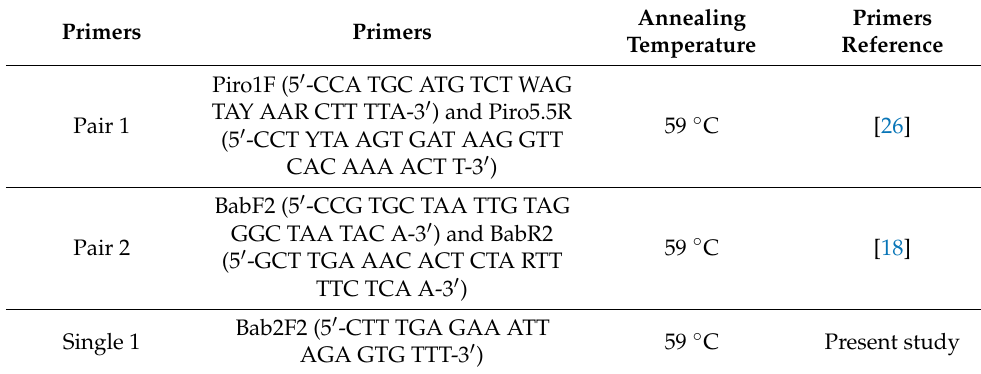
Table 2. Set of primers used for the sequencing of near-full length 18S rRNA